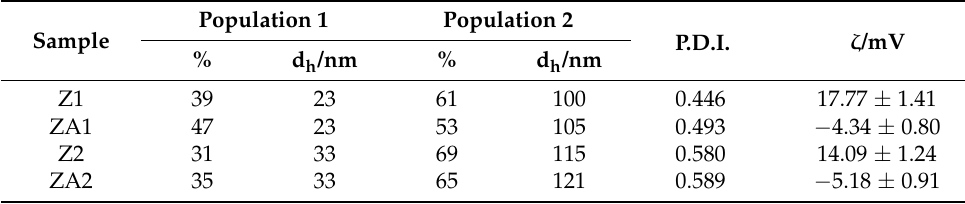
Table 1. DLS measurements of ZnO and ZnO/Au